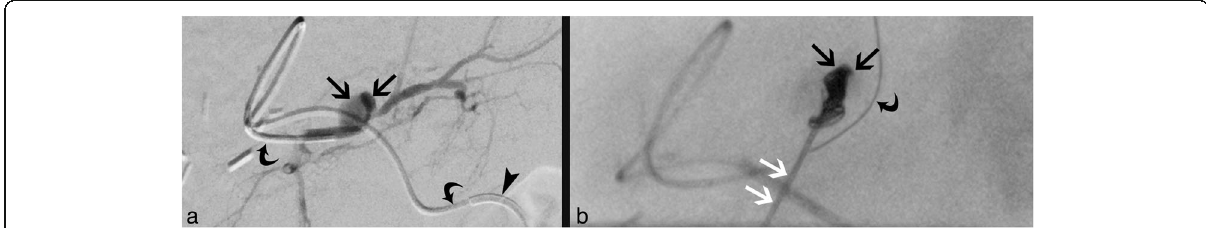
Fig. 1 Percutaneous transhepatic coil embolization. a Angiogram of the segment III liver artery using the coaxial technique (macrocatheter: arrowhead; microcatheter: curved arrow) prior to embolization shows localization and configuration of pseudoaneurysm (black arrows) as well as irregularity of the segment III liver artery due to vasospasm. b Fluoroscopy after percutaneous transhepatic access and embolization of the pseudoaneurysm (black arrow) via the CHIBA needle (white arrows) delineates coils within the pseudoaneurysm. The microcatheter (curved arrow) was advanced into a side branch of S III artery distal to the pseudoaneurysm to avoid coil